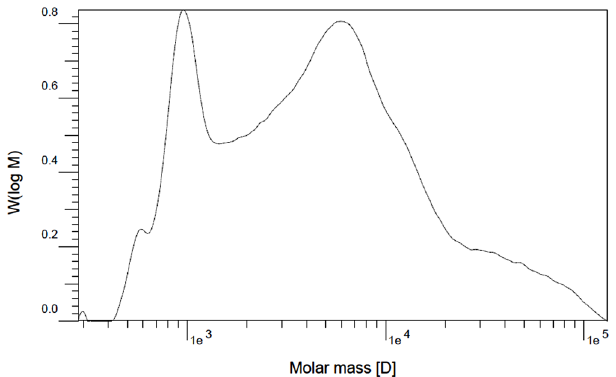
Figure 12. GPC chromatogram of PNIPAAM produced in SC-CO 2 at P = 20 MPa during 6 h, T = 70 °C, W i / W m = 1.5%, W t /W i = 83.3%, M w = 9326.5 (gr/mol), M n = 2355 (gr/mol) PDI = 3.96, and Mp = 956.8 (gr/mol).